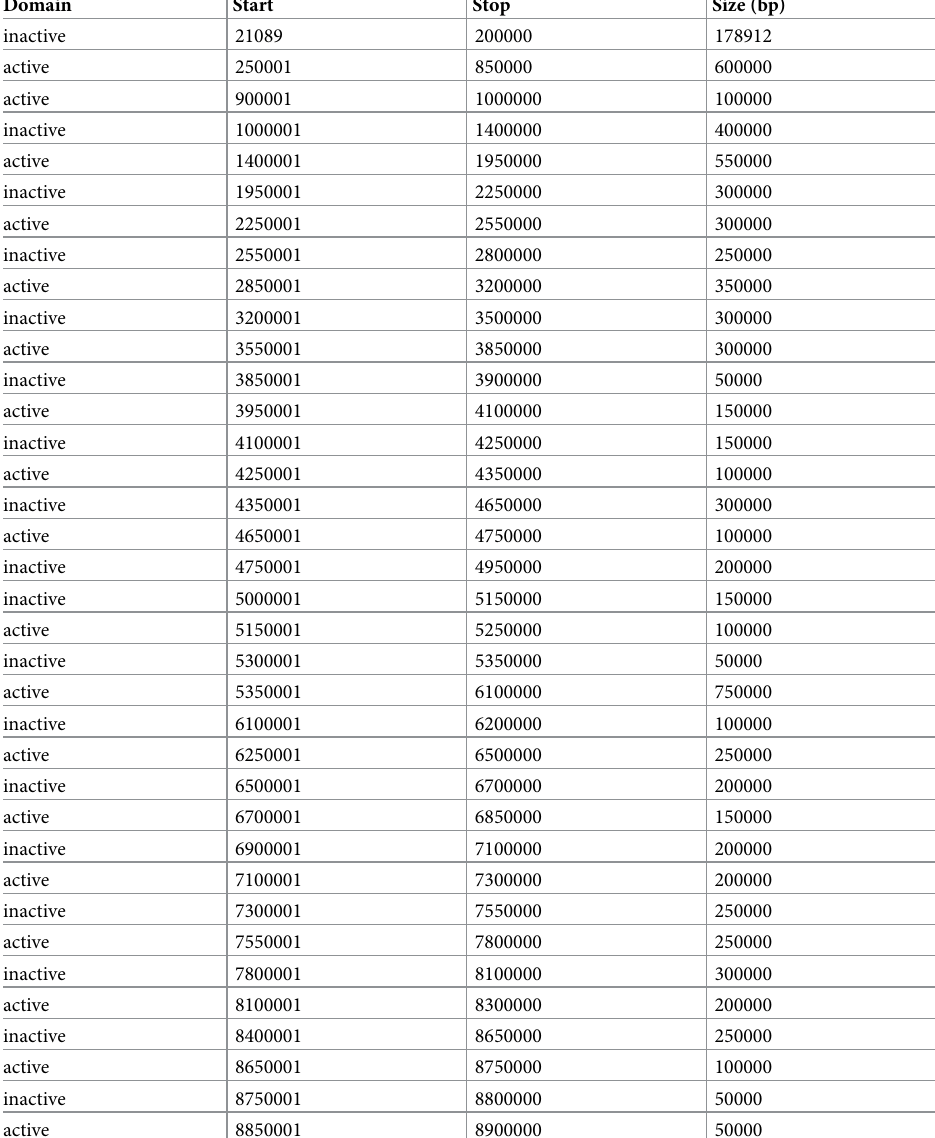
Table 4. Ch15 Active and inactive chromatin domains paint